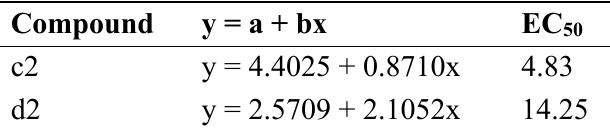
Table 2. EC values of compounds c2 and d2 50